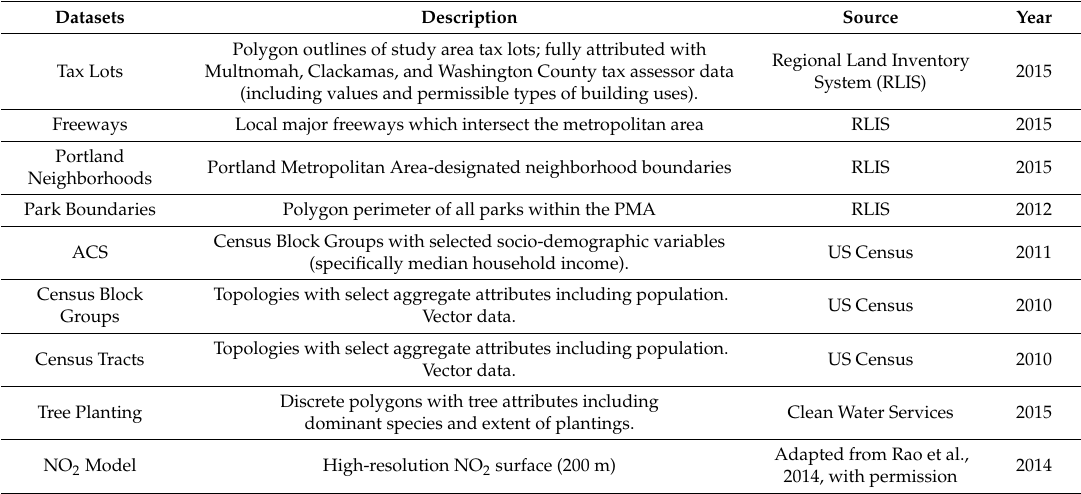
Table 1. Description and source of data sets used in